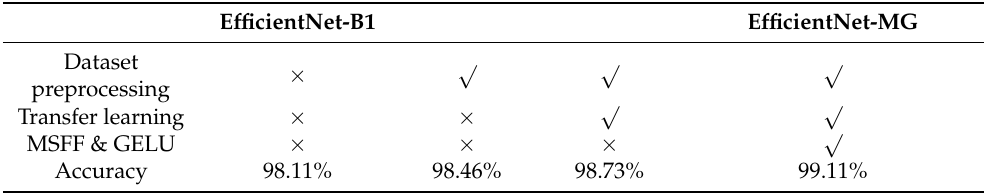
Table 8. Ablation study from EfficientNet-B1 to the proposed EfficientNet-MG. EfficientNet-B1 EfficientNet-MG